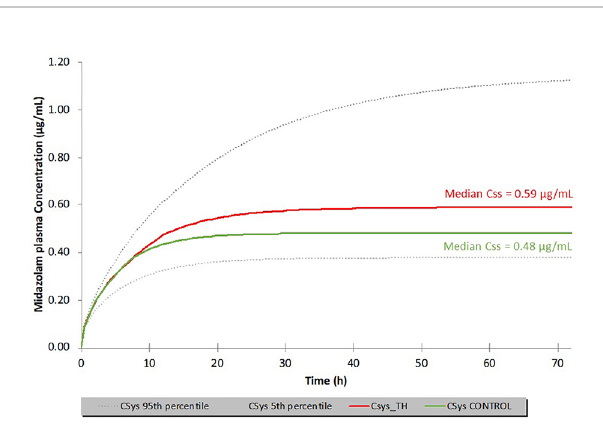
FIGURE 7 | Simulated midazolam median systemic plasma concentrations (C sys ) in neonates (n = 19; 0.05 mg/h/kg for 72 h; total dose 3.6 mg/kg) under normothermic (green line) versus hypothermic (red line) conditions. Therapeutic hypothermia (TH) was assumed to induce a 20% change in each of the following parameters: cardiac output (decreased), unbound fraction (fu, increased), blood/plasma ratio (B/P ratio, decreased) and 1-OH-midazolam formation intrinsic clearance (CL, decreased). Dashed lines represent the 90% CI for the hypothermic condition. C ss : steady state